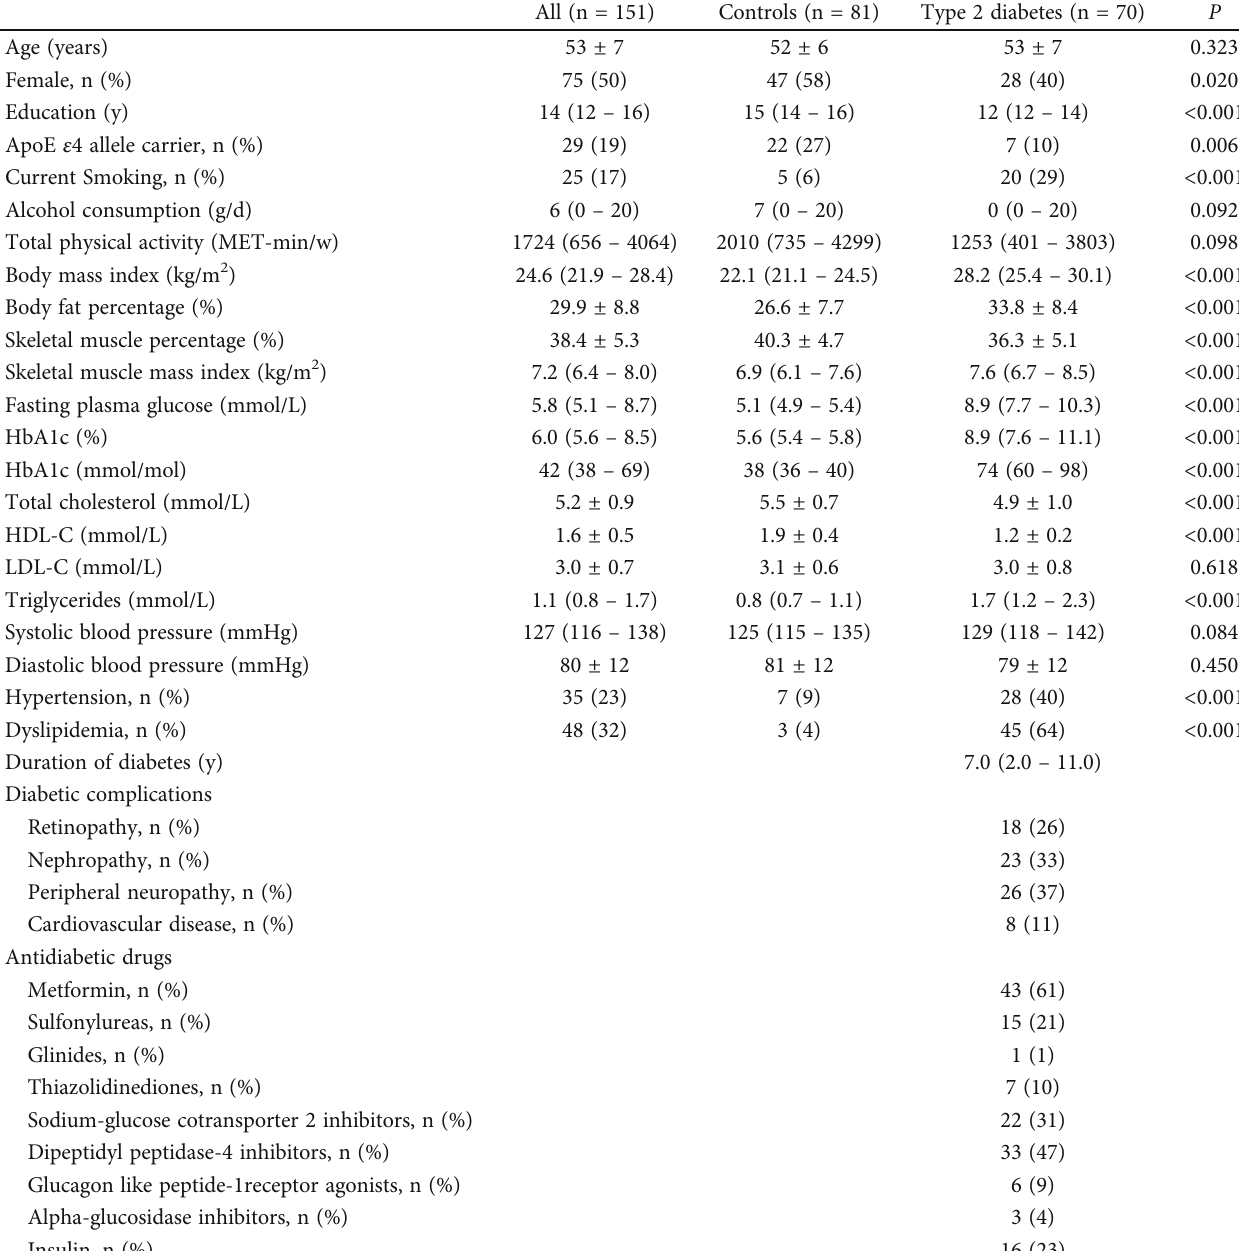
Table 1: Clinical characteristics of study